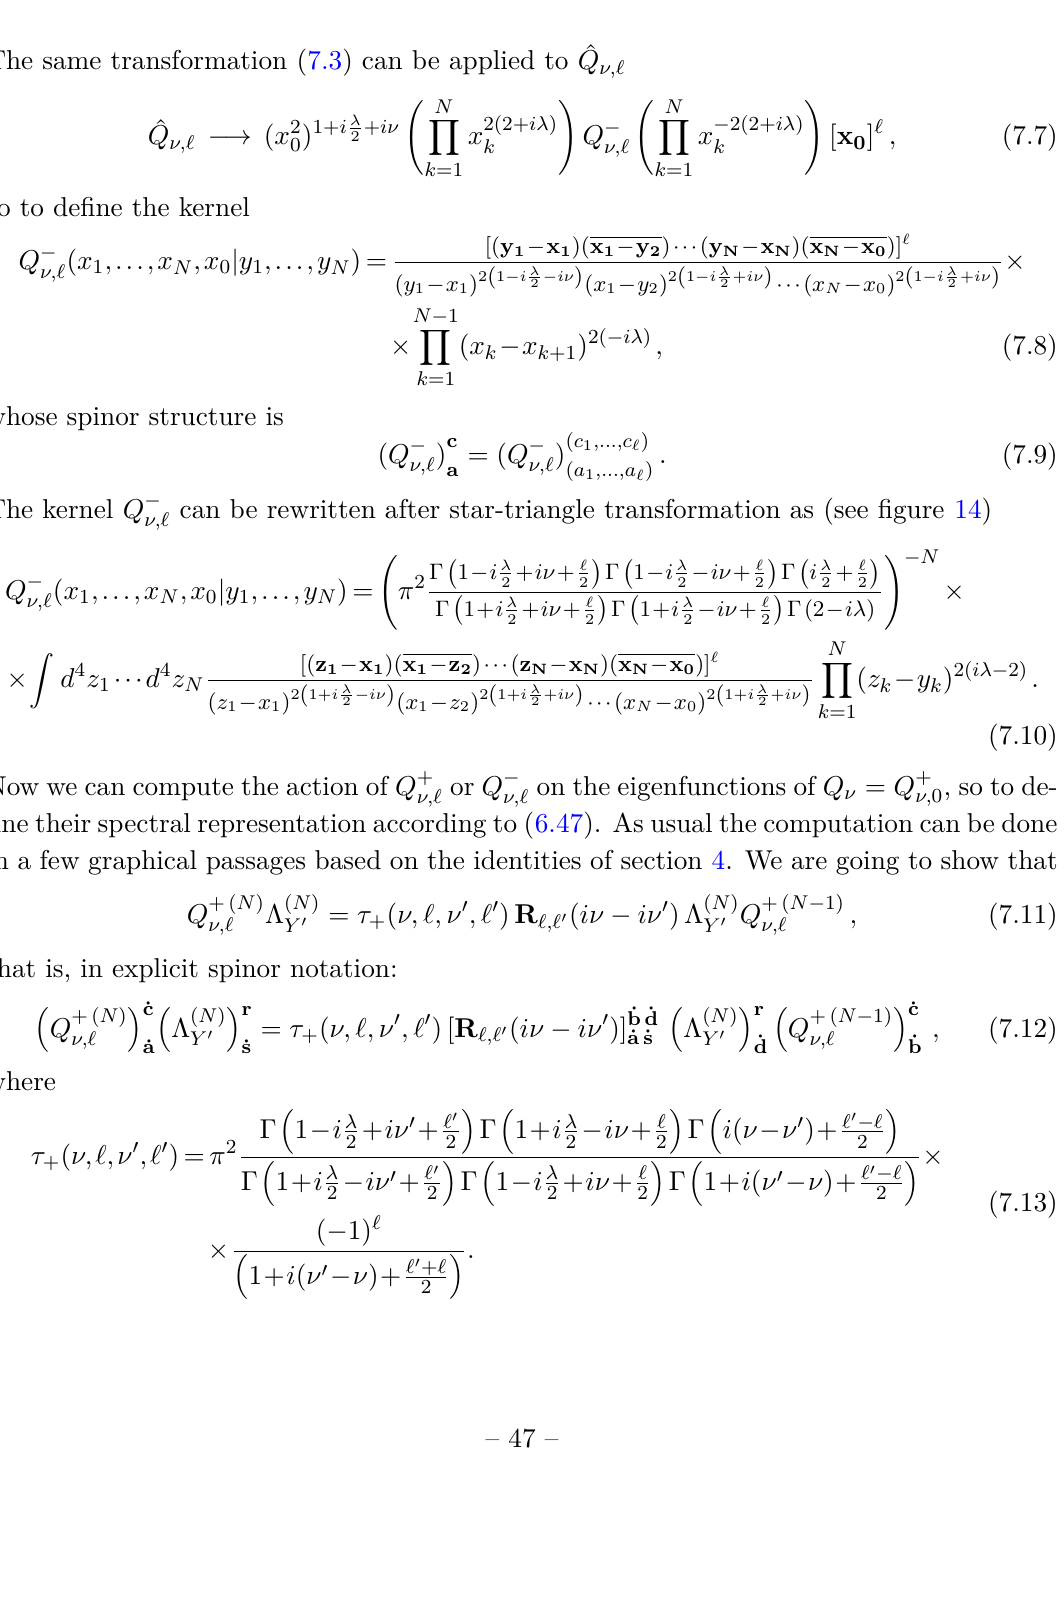
Figure 14 . On the left, the kernel Q + the kernel Q − ( x 1 , x 2 , x 3 , x 0 | y 1 , y 2 , y 3 ν,‘